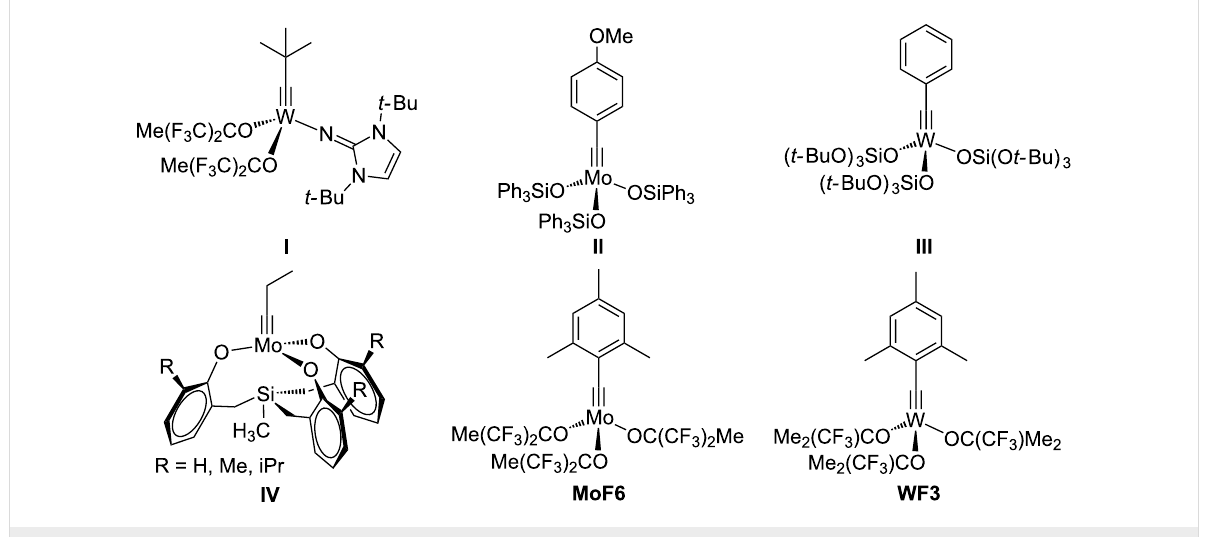
Figure 1: Selected homogeneous catalysts for alkyne metathesis.